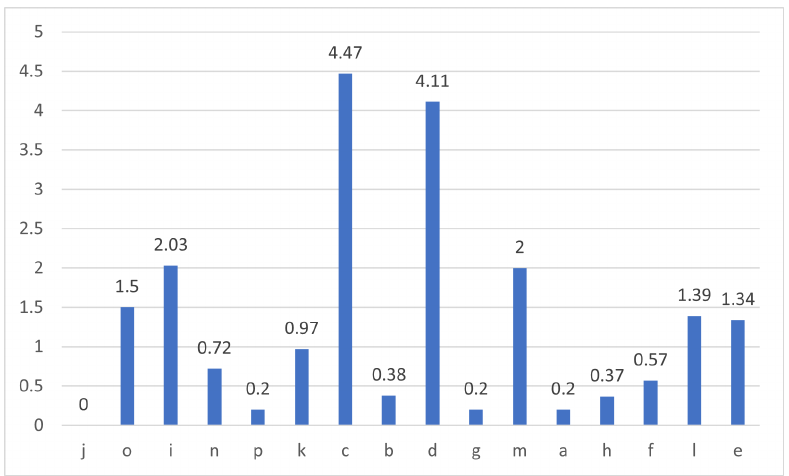
Figure 7. RSSI difference vs. reader–antenna